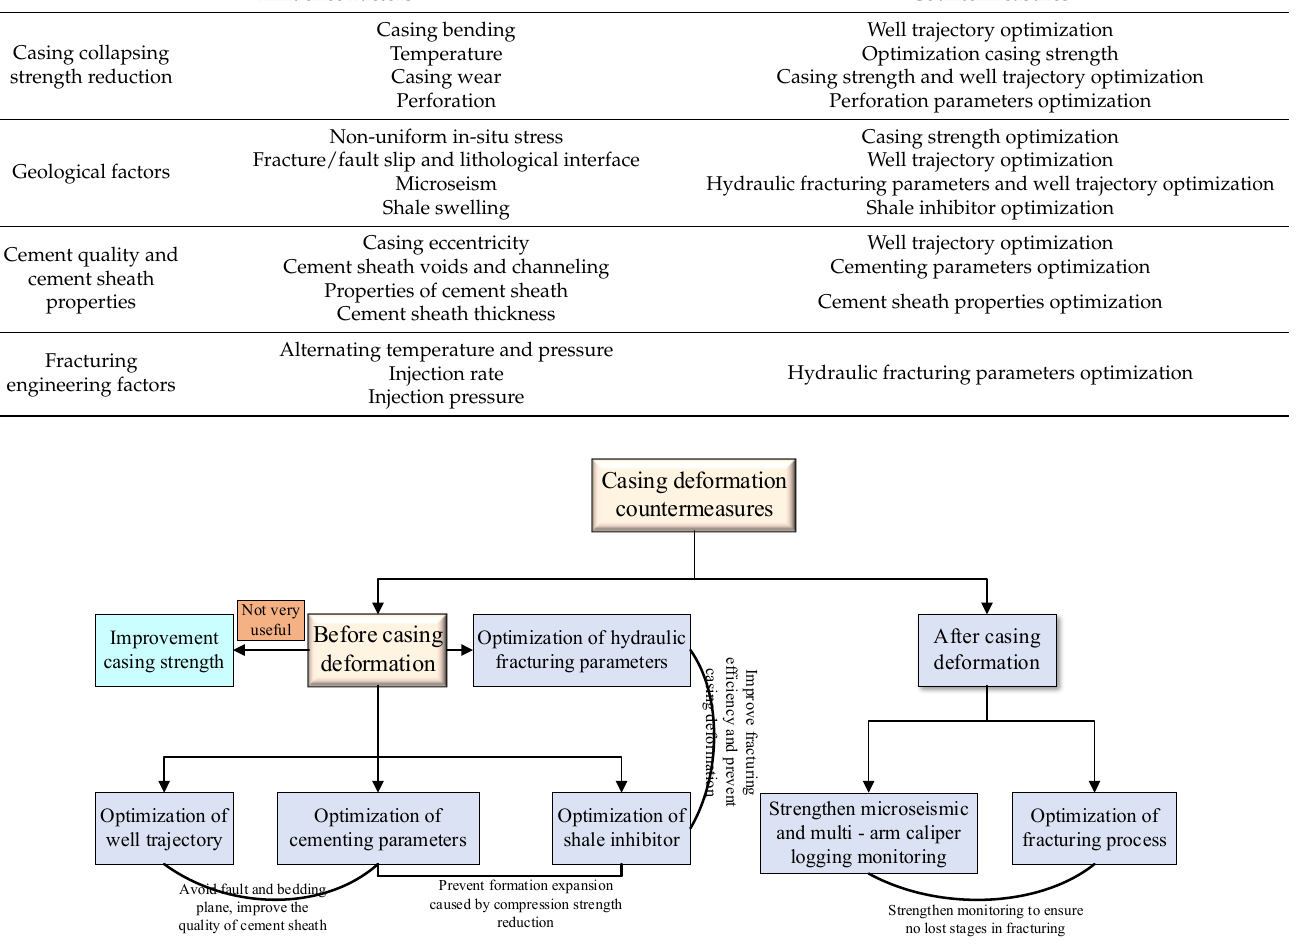
Figure 14. Countermeasures before and after casing deformation. Table 3. The countermeasures for influence factors.